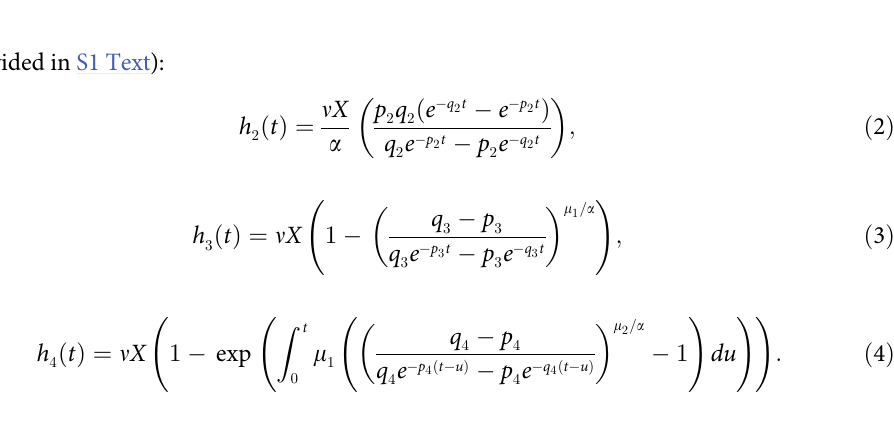
Fig 1. Schematic of a general multistage clonal expansion model. Multistageclonalexpansionmodels are continuous-time Markov chain models in which normal cells undergoa series of geneticchangesthat lead to a state of clonalexpansionfollowedby progressionto malignancy.